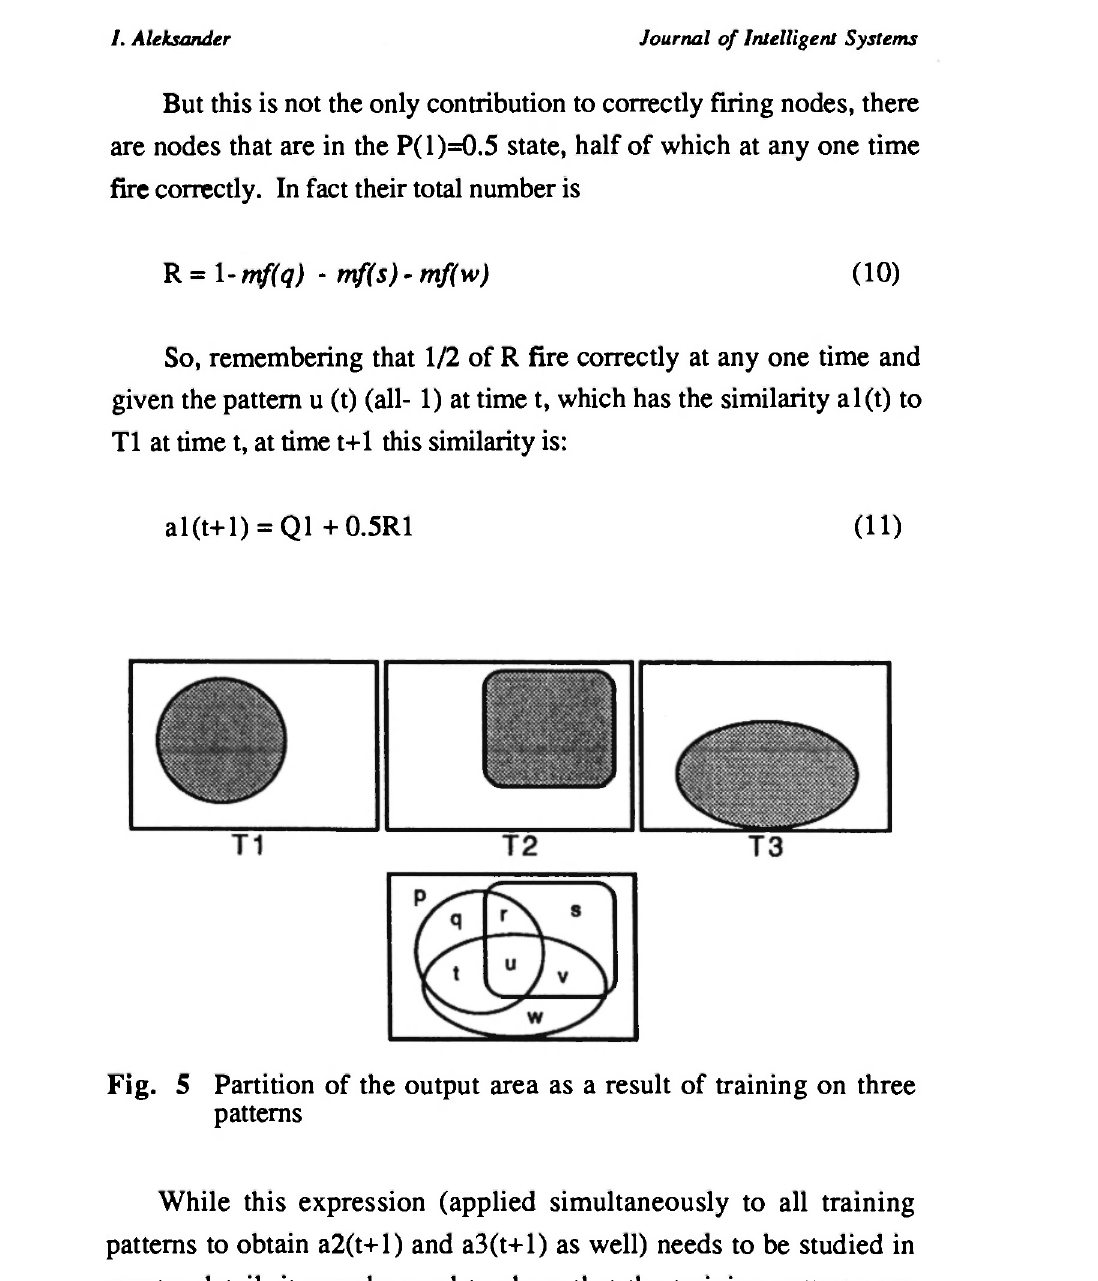
Fig. 5 Partition of the output area as a result of training on three